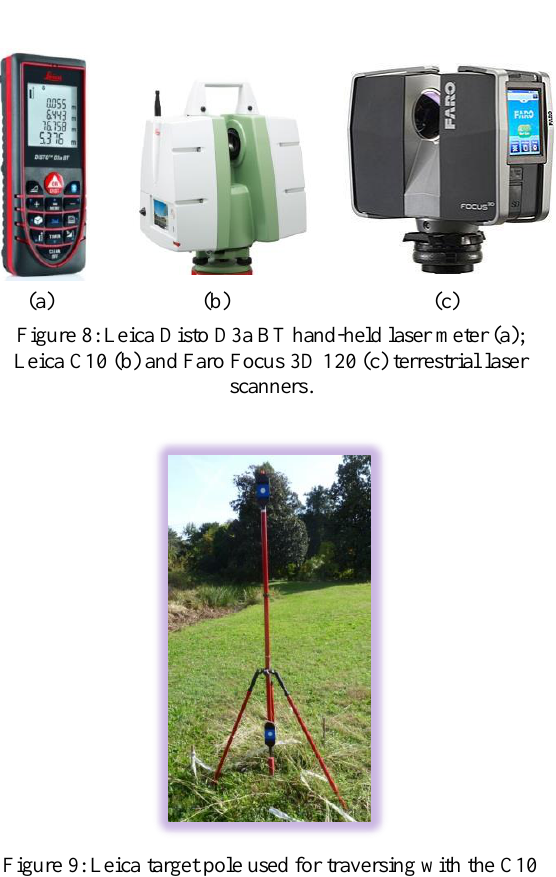
Figure 7: Workflow adopetd for data acquisition and processing